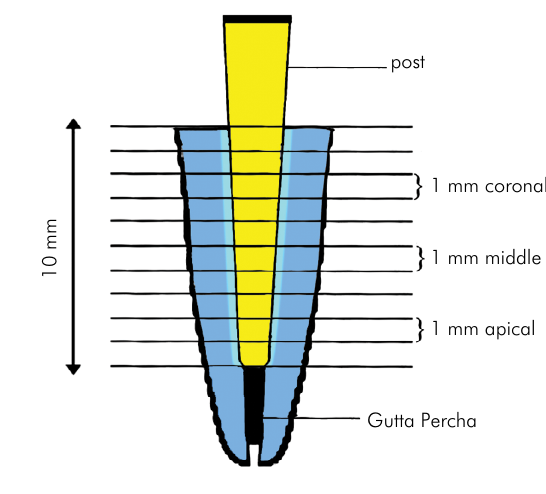
Figure 1. Schematic view of specimen preparation for the tensile test.